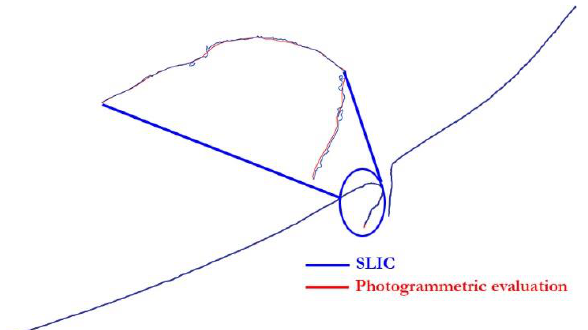
Figure 6. Shoreline extraction by SLIC